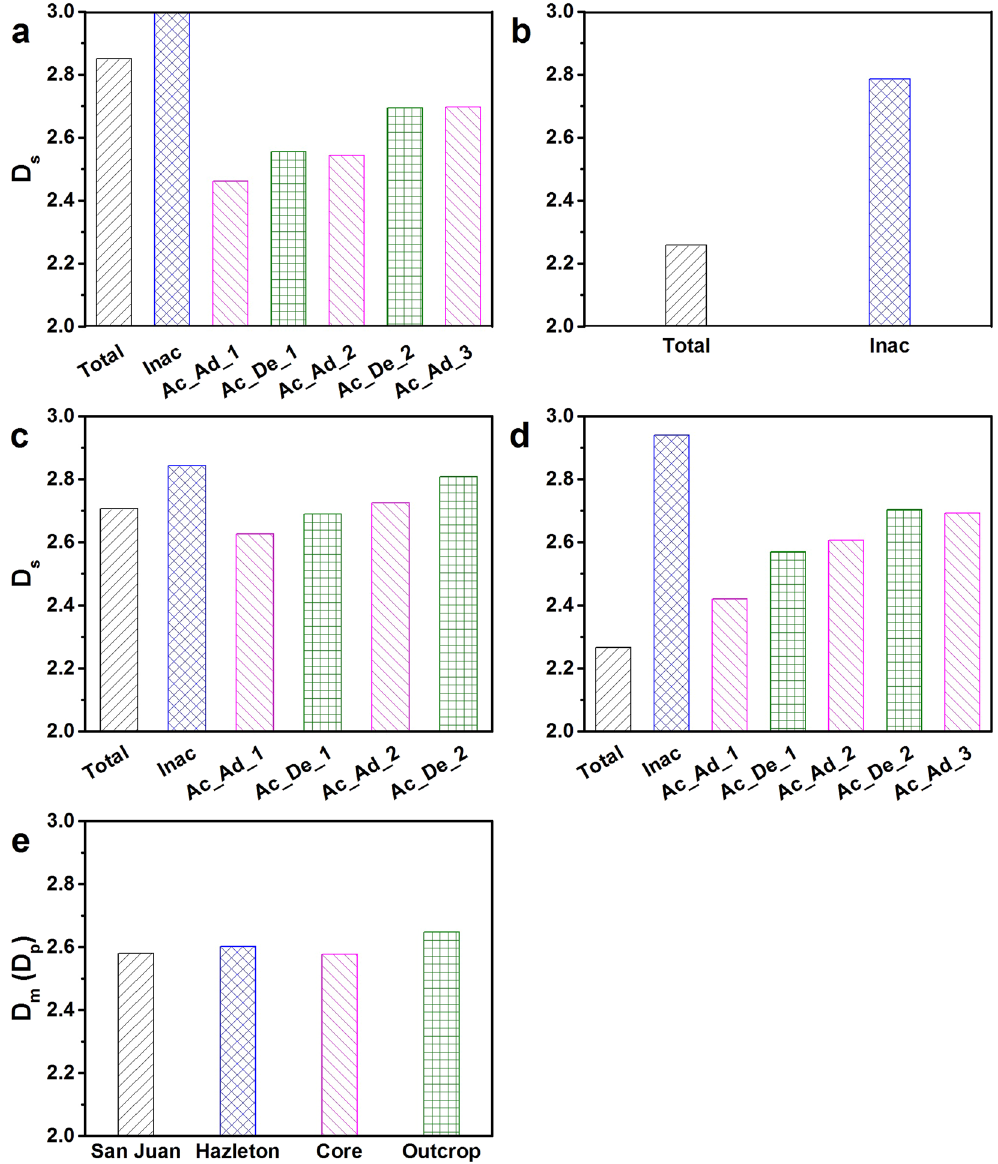
Figure 3. Fractal dimension from different techniques for total, accessible and inaccessible pores. ( a ) San Juan coal; ( b ), Hazleton coal; ( c ) Marcellus drilled core shale; ( d ) Marcellus outcrop shale; ( e ) vacuum condition of four samples using SAXS. (Note: Total: Total pores; Inac: Inaccessible pores; Ac_Ad_1: Accessible pores for linear section 1 of adsorption; Ac_De_1: Accessible pores for linear section 1 of desorption; Ac_Ad_2: Accessible pores for linear section 2 of adsorption; Ac_De_2: Accessible pores for linear section 2 of desorption; Ac_Ad_3: Accessible pores for linear section 3 of